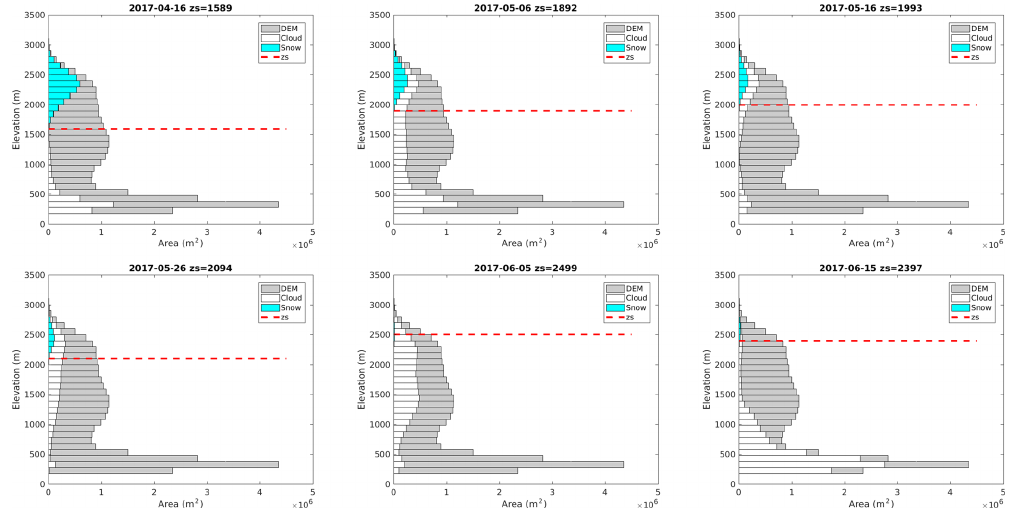
Figure 1. Time series of snow and cloud cover area distribution by elevation band over tile 31TCH (tile location in Fig. 5). The dashed red line indicates the position of z s as determined by the LIS algorithm. The corresponding snow maps are shown in Fig. 2.